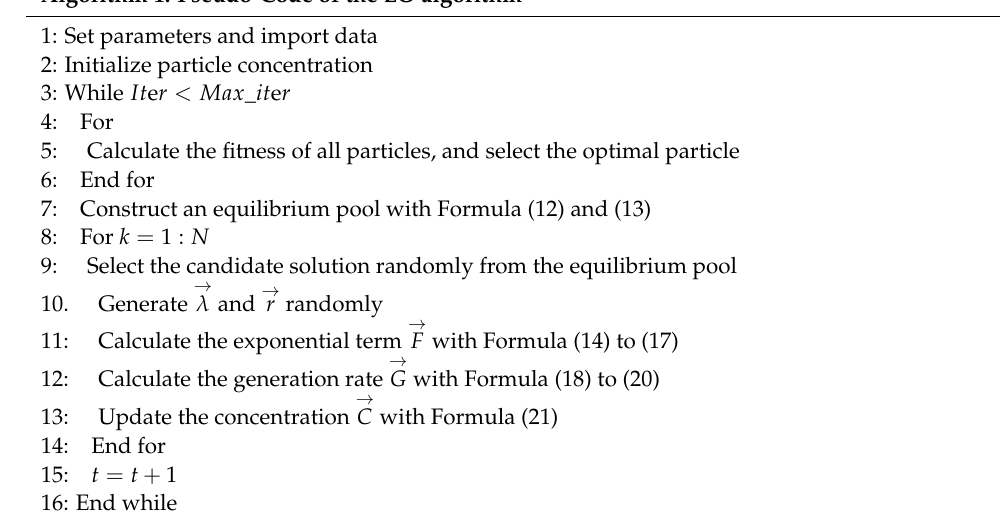
Algorithm 1: Pseudo-Code of the EO